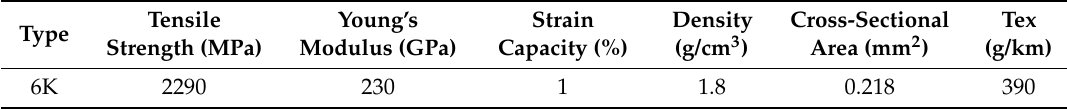
Table 1. Physical and mechanical properties of the warp carbon yarns (impregnated).